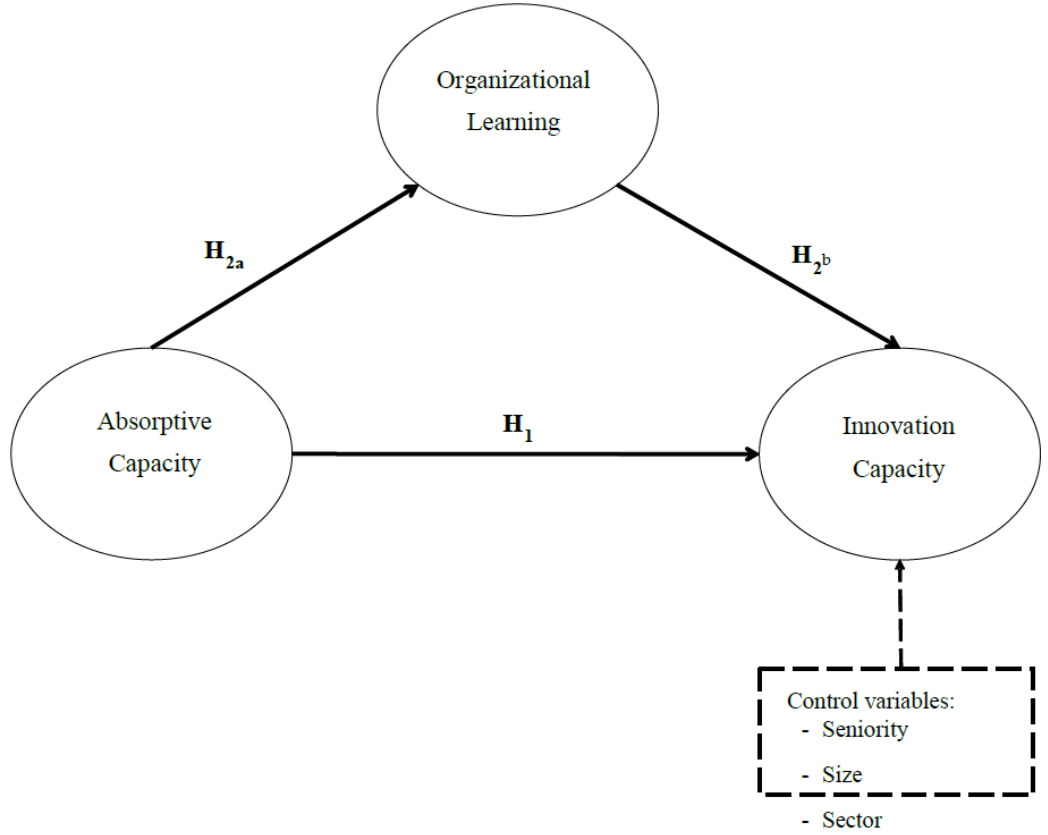
Figure 1. Research Model.